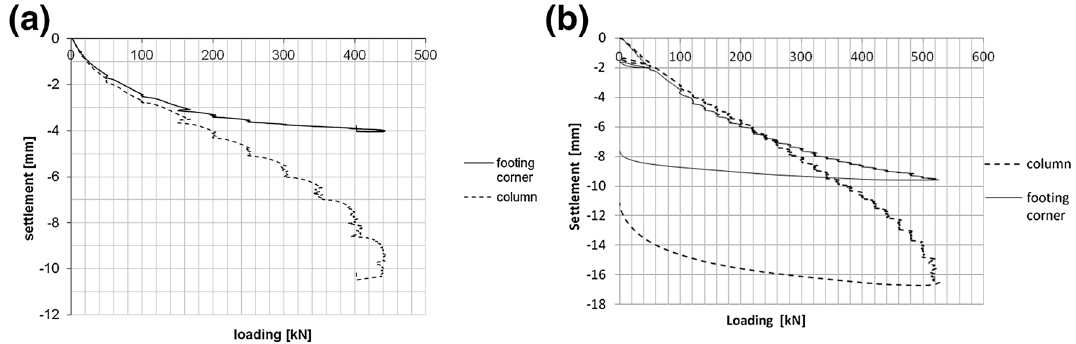
Fig. 18 Recorded settlements of the column and of the footing corner: a footing F6; b footing